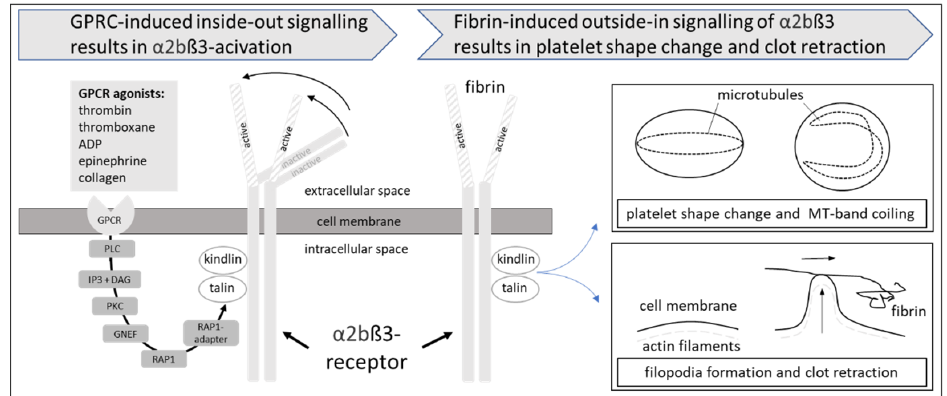
Figure 1. Inside-out and outside-in signaling of the platelet α IIb β 3-receptor. Inside-out signaling is defined as the activation of the extracellular part of the α IIb β 3-receptor induced by intracellular signal transduction events including G-protein coupled receptors (GPCR), phospholipase C (PLC) and the second messengers diacylglcerol (DAG) and inosittrisphosphate (IP3), protein kinase C (PKC), RAS-related protein 1 (RAP1), RAP1-adapter, talin, and kindlin. Outside-in signaling consists of fibrin-binding to the activated α IIb β 3 receptor, subsequent activation of complex intracellular signal transduction pathways (not shown), leading to a shape change induced by the microtubule system as well as filopodia formation and clot retraction induced by actin